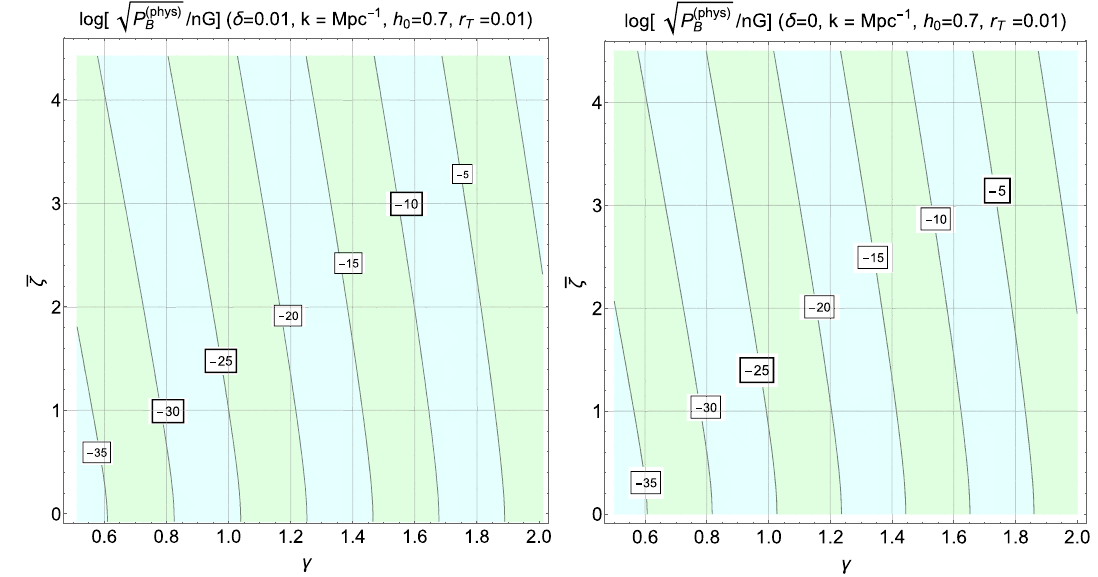
Fig. 5 The parameter space is illustrated in the (γ, ζ) plane. The numbers appearing on the various contours correspond to the common logarithm (cid:21) ( phys ) P expressed in nG of B